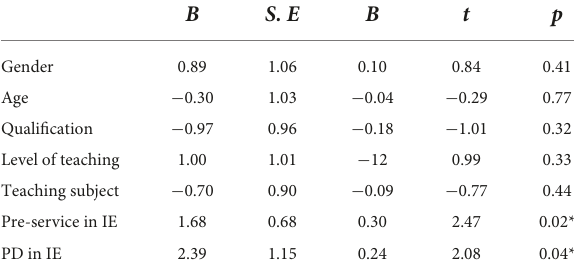
TABLE 5 Summary of demographics regressed on instruction.